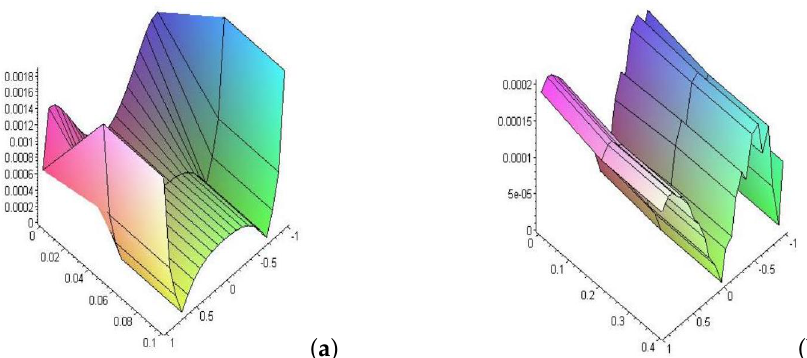
Figure 4. ( a , b ) Shows the error of Equation (44) using the Hilbert kernel for the nonlinear and the linear cases at time t = 0.1, N = 20.